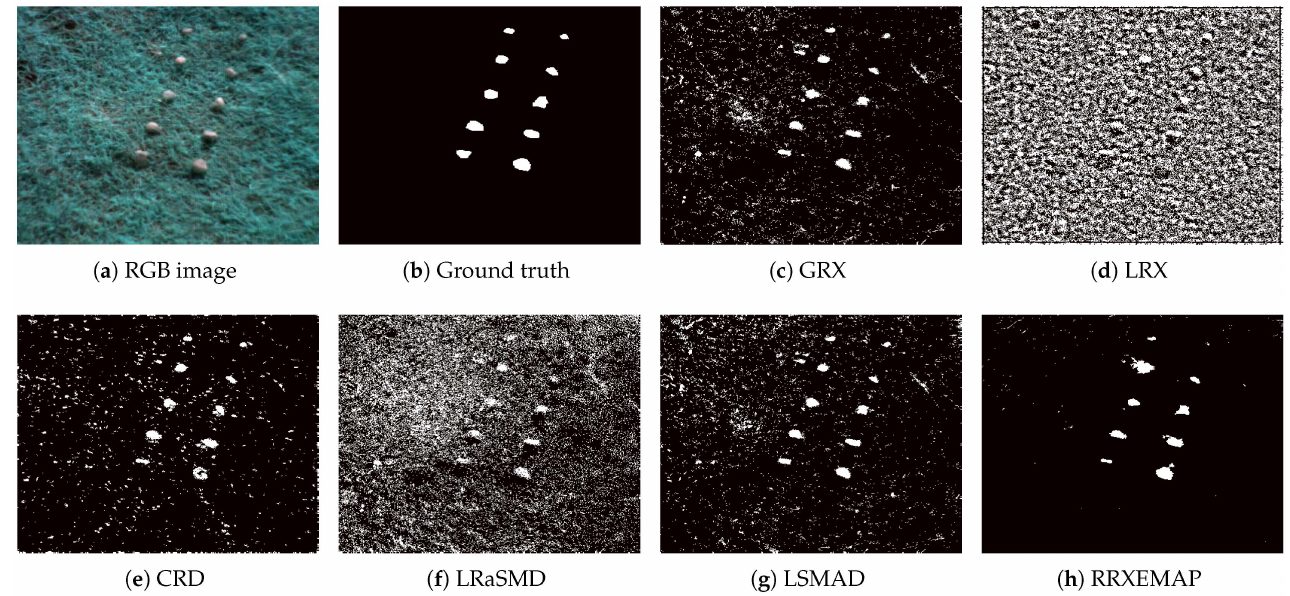
Figure 10. Color detection maps obtained by different algorithms for the Cri dataset.